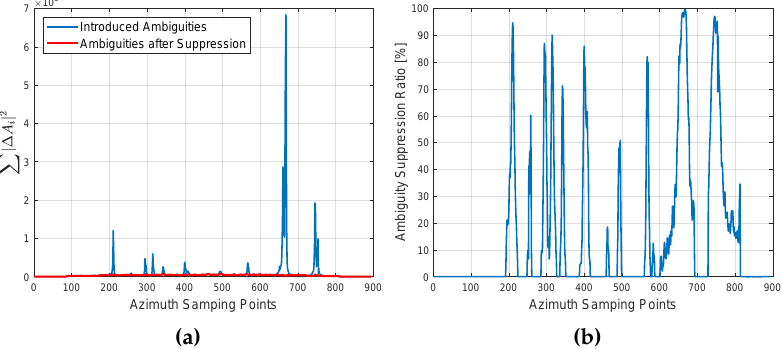
Figure 7. Comparison curves of the azimuth ambiguities before and after the suppression procedure. ( a ) Statistical total energy results: blue line, the introduced azimuth ambiguities; red line, the remaining azimuth ambiguities after suppression. X-axis represents the azimuth time with sampling points. Y-axis shows the statistical result based on Equation (15). ( b ) Calculated ratio of the suppressed energy to the total energy of the azimuth ambiguities. X-axis represents the azimuth time with sampling points. Y-axis shows the suppression ratio expressed as a